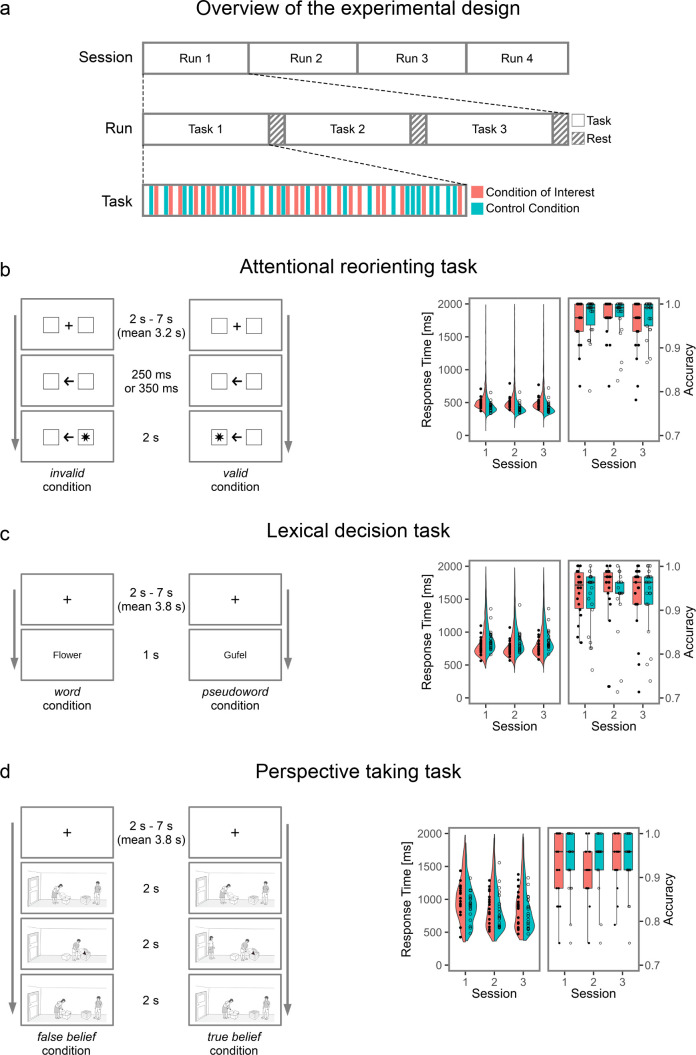
Experimental design and behavioral results.(a) Experimental design. Each of the four sessions consisted of four fMRI runs. In each run, all three tasks were presented in a pseudo-randomized order and analyzed in an event-related fashion. (b) Attentional reorienting task. In each trial, a directional arrow appeared at the center of the screen to direct the subject’s attention to the left or right. In 75% of the trials, the arrow correctly predicted the position of the target (valid condition), in 20% of the trials, the target appeared on the opposite side and subjects had to reorient their attention (invalid condition). In 5% of the trials, no response was prompted (catch condition). Subjects indicated the side of the target via button press. (c) Lexical decision task. Participants performed lexical decisions (word or pseudoword condition) based on concrete German nouns or well-matched pseudowords. (d) Perspective taking task. In each trial, character A places a target object in a container. Thereafter, character B changes the location of the target object. Character A has left the room (false belief condition) or watches the relocation of the object (true belief condition). Character A then searches for the target object at the location congruent with her / his knowledge (expected) or at the contradicting location (unexpected). Participants had to indicate via button press whether character A searched at the expected location or not. Behavioral results for each task are shown in the right panel, separately for each session. Single subject data is overlaid as circles.